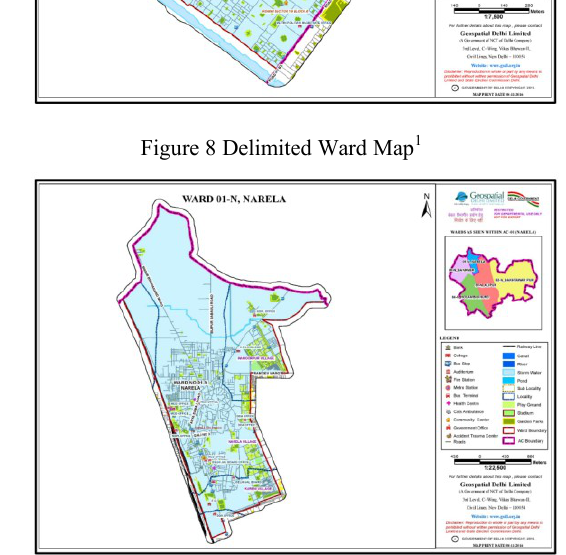
Figure 9 Delimited Ward Map